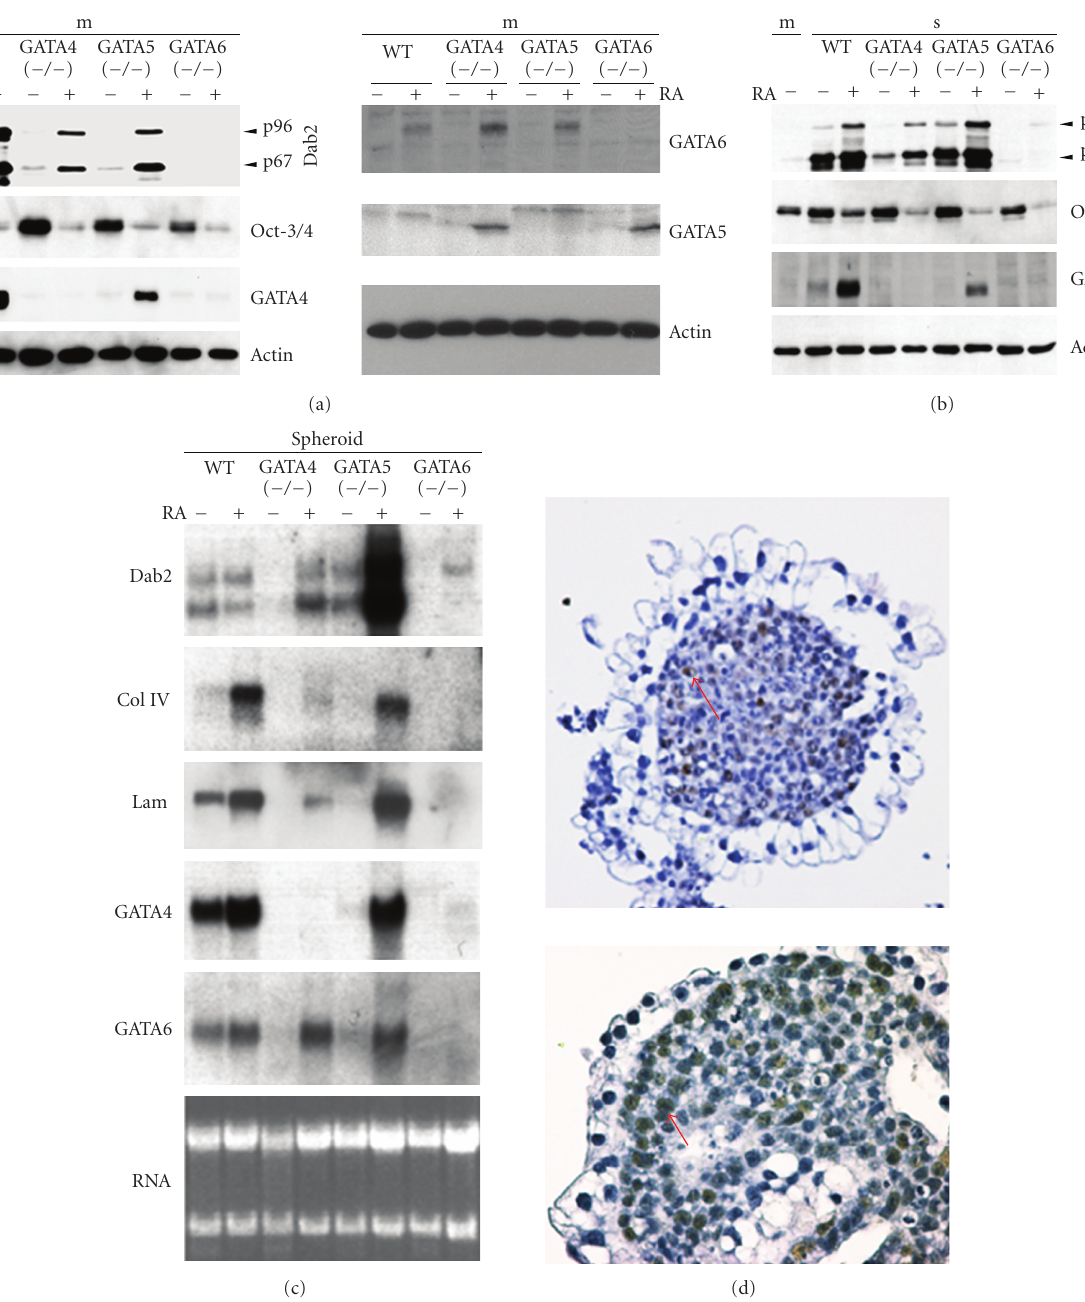
Figure 1: Endoderm lineage di ff erentiation of ES cells in vitro. Approximately 1 × 10 6 ES cells of wildtype or deficient in one of GATA factor were seeded on 100 mm plates as a monolayer culture (m) or cultured in suspension to allow cell aggregation to form spheroids (s). The cells were also treated with 1 μ M retinoic acid (RA) or DMSO control. Following a 4-day culture period, cell lysates from monolayer (a) or from spheroids (b) were prepared for Western blotting analysis. (c) mRNA was prepared for Northern blot analysis. (d) Preservation of Oct-3/4 protein in embryoid bodies: embryonic stem cells were cultured in medium lacking LIF in suspension to allow the formation of cell aggregates. The embryoid bodies from a 4-day suspension culture were fixed in formalin, embedded in para ffi n, sectioned, and immunostained for Oct-3/4 protein. Representative stainings of two embryoid bodies are shown (left panel, 40 × , and right panel, 200 ×